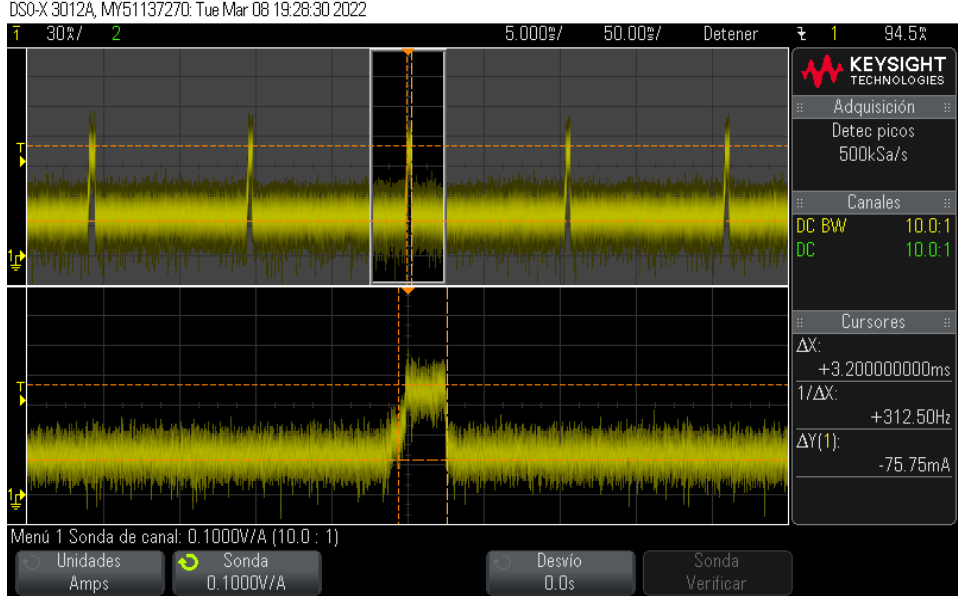
Figure 5. Power drawn at the smart IEQ sensor node when in operation.